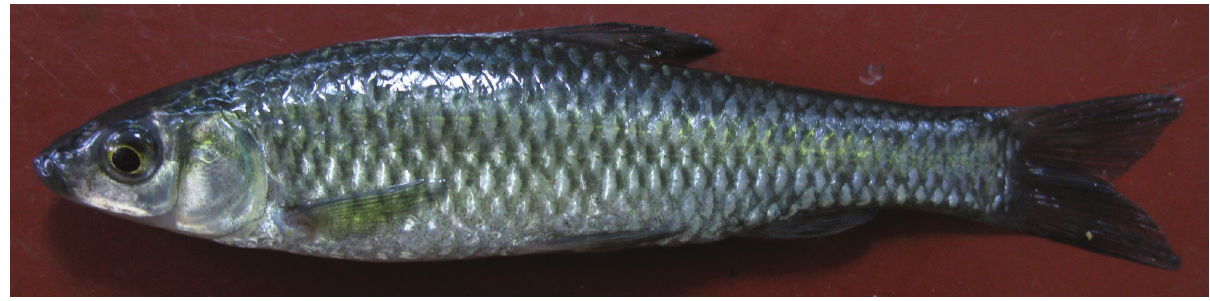
Figure 1. The adult Pseudorasbora parva